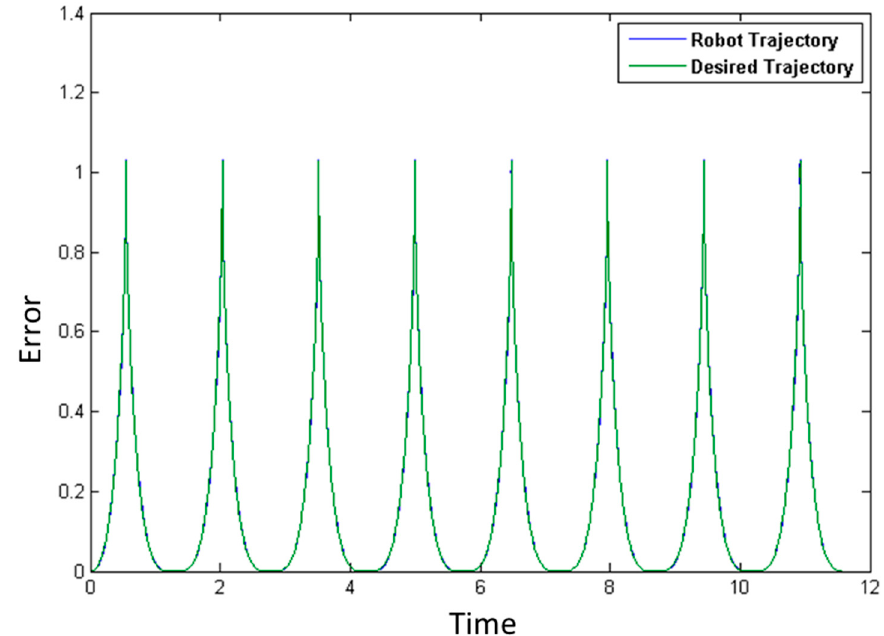
Figure 15. Best trajectory for FGSO1 without noise.